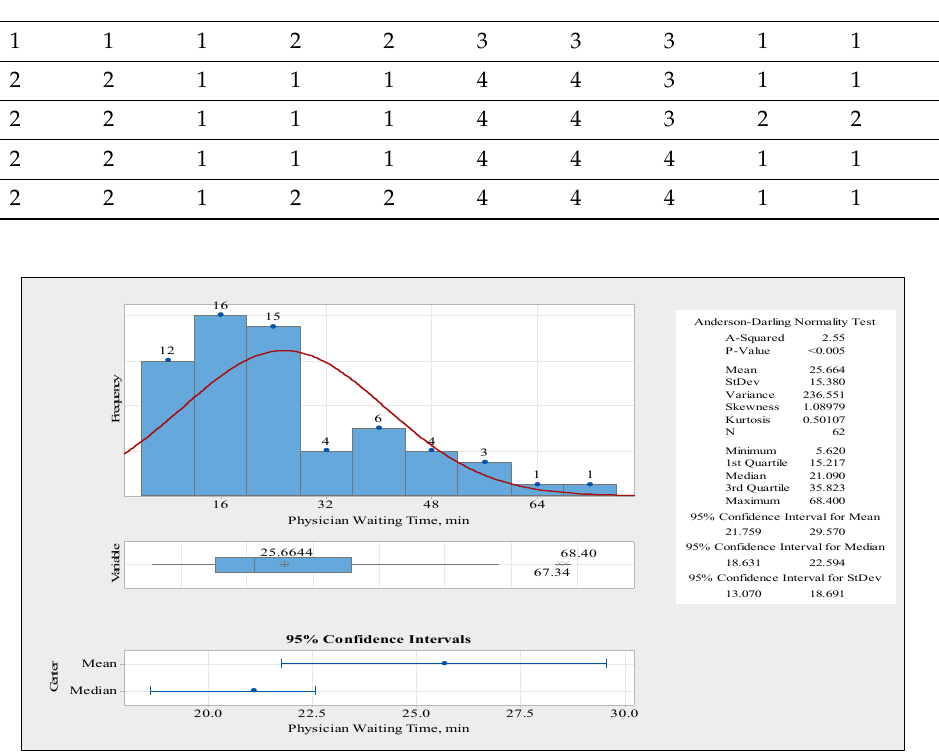
Figure 10. Summary report for the physician waiting time in the current state.